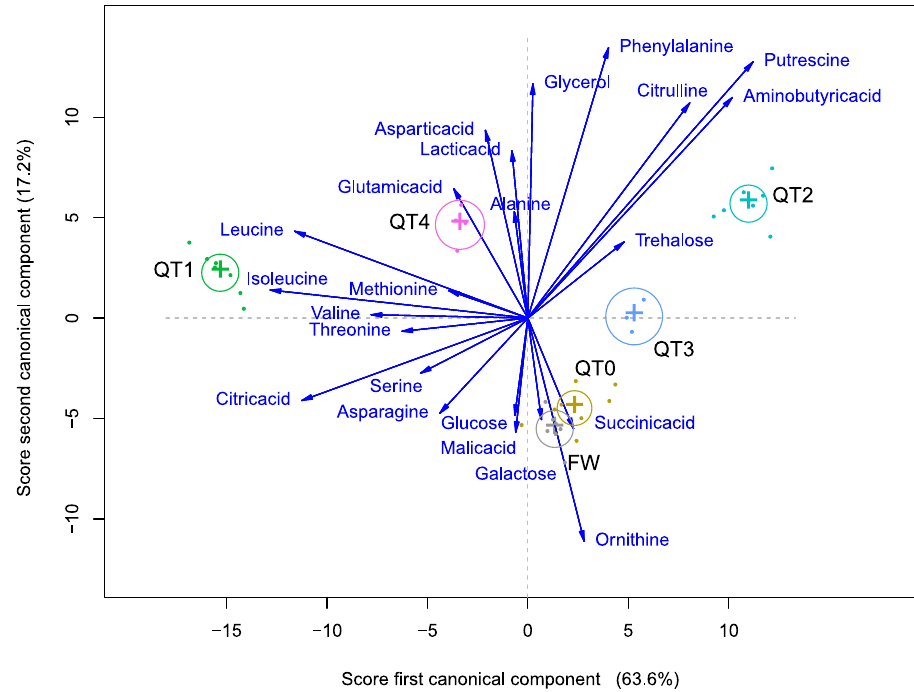
Fig. 6 Canonical discriminant analysis of concentrations of metabolites. Three canonical functions discriminate ages and castes signi fi cantly, of which we show scores for the fi rst two. Average scores for each caste and age are shown, plus canonical structure coef fi cients of each metabolite as vectors from the origin. These are proportional in length to the magnitudes of the correlations of each metabolite with the scores of the discriminant functions and show how information from each metabolite aids in discriminating castes and ages. The numbers of replicates per group are provided in Supplementary Table